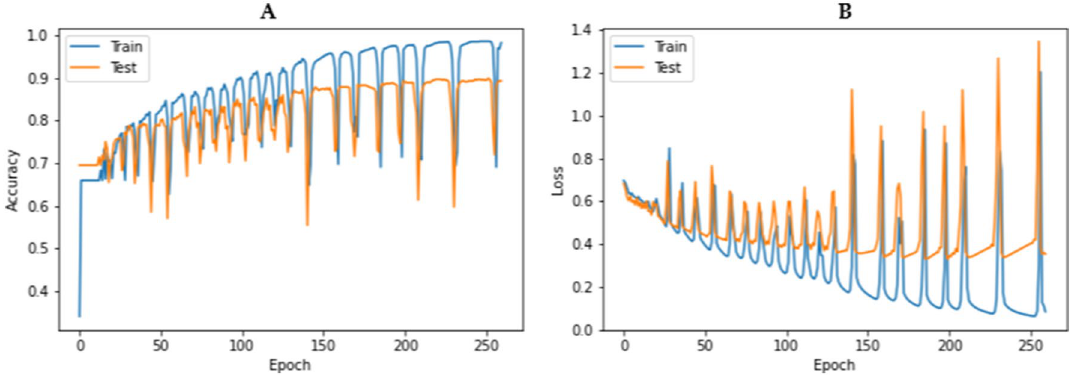
Figure 4. Model accuracy and loss of AptaNet on our benchmark dataset. Where ( A ) is model accuracy, and ( B ) is model loss of